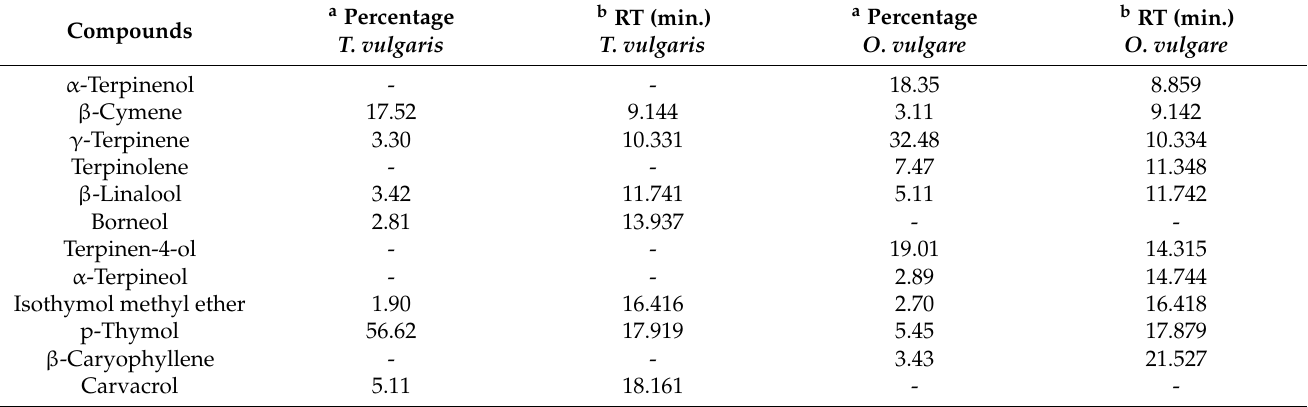
Table 4. Chemical composition of essential oils extracted from leaves of T. vulgaris (thyme) and O. vulgare (oregano) determined by gas chromatography coupled to mass detection